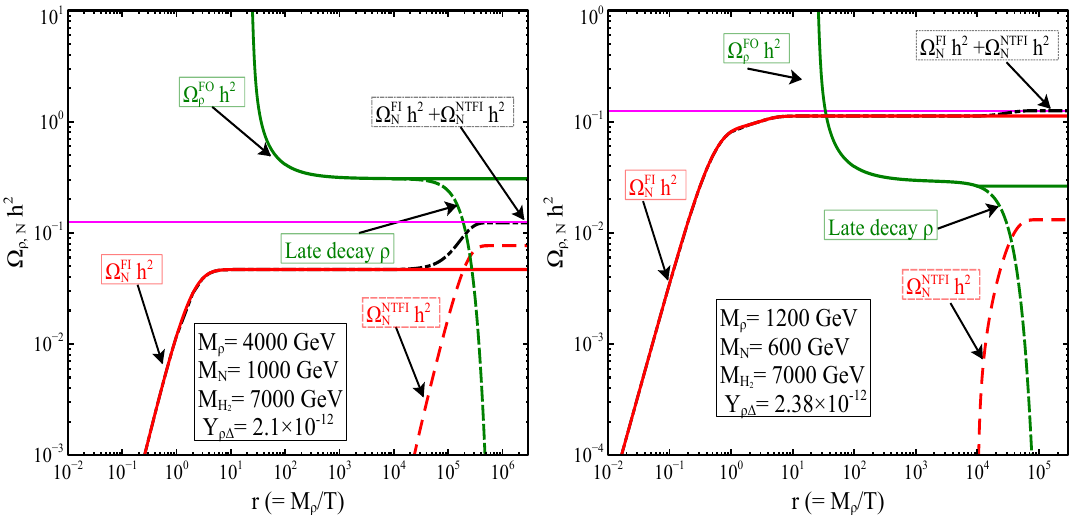
Figure 13 . Evolution of ρ and N abundances including the decay of ρ . In the Right panel, the late decay of ρ gives significantly large contribution. In the Left panel, thermal freeze-in is the most